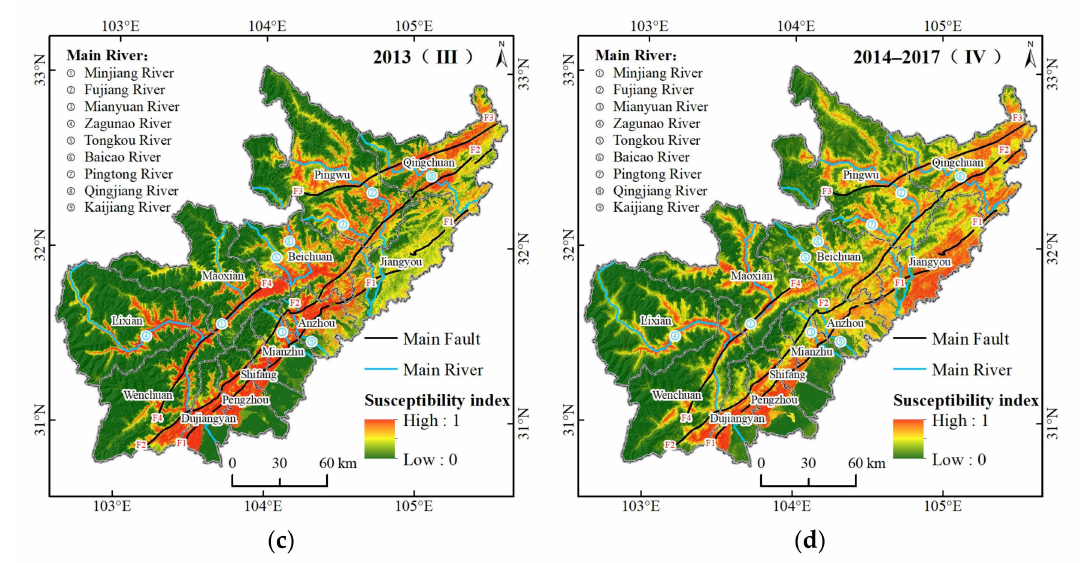
Figure 6. Geohazard susceptibility in four periods: ( a ) 2008 (I); ( b ) 2009–2012 (II); ( c ) 2013 (III); and ( d ) 2014–2017